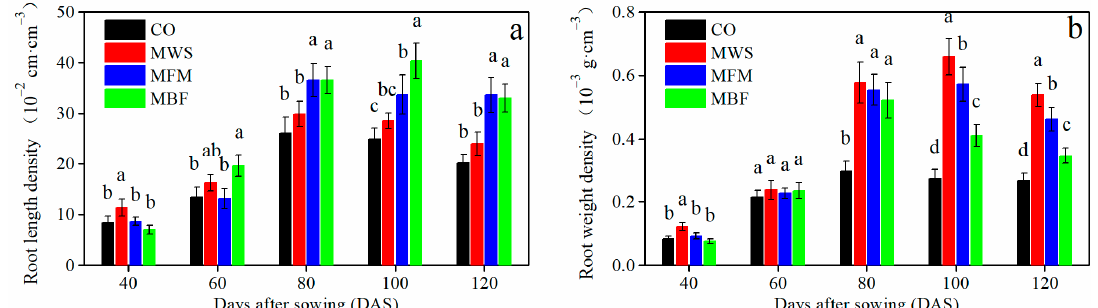
Figure 7. The root-length density (RLD) and root-weight density (RWD) under indicated treatments on different days after sowing during the 2015 growing season. The abbreviations of the treatment names are the same as those described in Figure 2. Means of the RLD or RWD within the same days after sowing sharing the different lowercase letters are significantly different at p < 0.05.